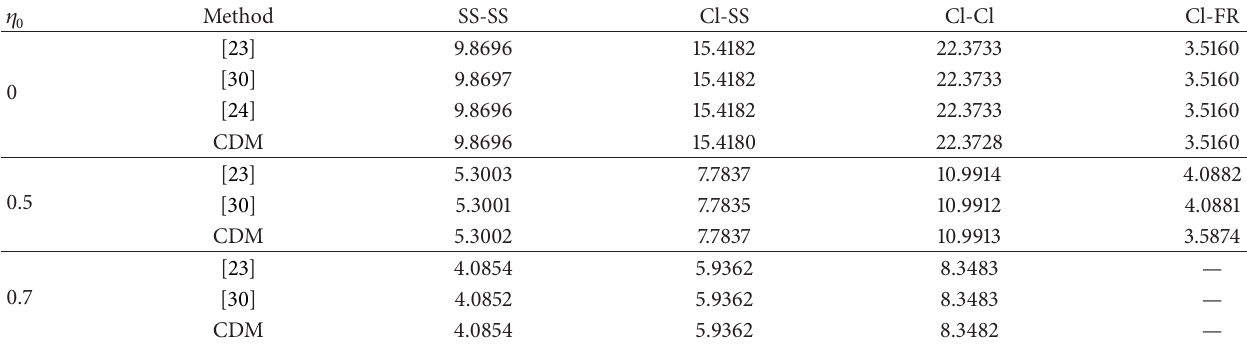
Table 5: Numerical comparison between the results obtained with CDM and [23, 24, 30] of a SWCNT and for different values of parameter 𝜂 0 .